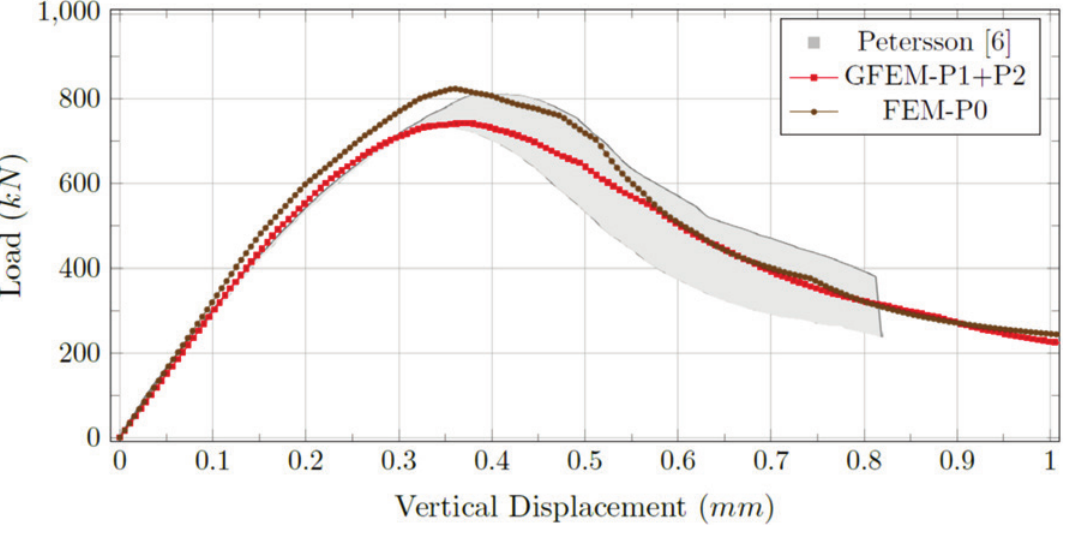
Simulations using an exponential damage law (equation